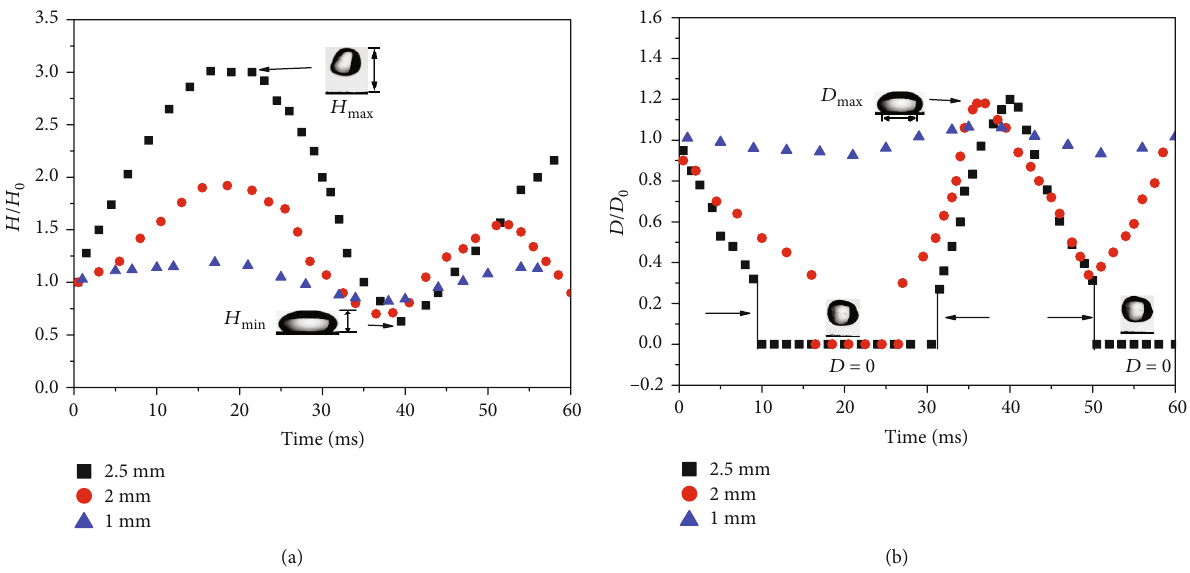
Figure 6: The change rate of the droplet with time under di ff erent amplitudes: (a) height of droplet and (b) wetting diameter of